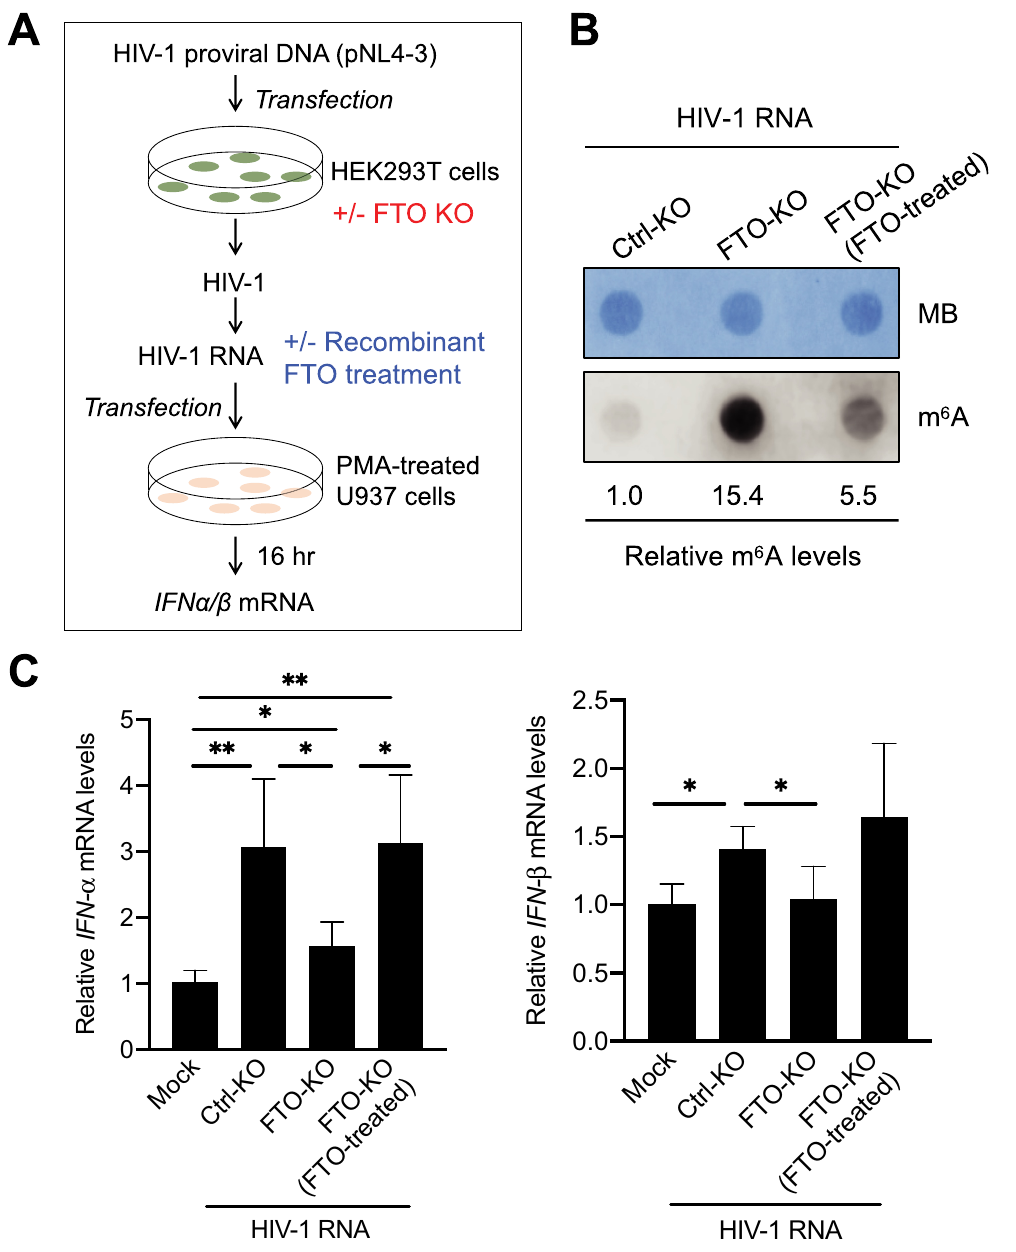
Fig 8. IFN-I mRNA expression is rescued in U937 cells transfected with m 6 A-increased HIV-1 RNA upon recombinant FTO treatment. (A) A schematic diagram of the experimental approach. (B) HIV-1 RNA isolated from virions generated from FTO-KO HEK293T cells was treated with or without recombinant FTO. HIV-1 RNA derived from Ctrl-KO HEK293T cells was used as a control. m 6 A levels of HIV-1 RNA (50 ng/sample) were measured by the m 6 A dot-blot assay. Methylene blue (MB) staining was used as an RNA loading control. (C) HIV-1 RNA (250 ng) was transfected in PMA-differentiated U937 cells (5 × 10 5 ). Mock transfection of U937 cells without RNA was used as a negative control. At 16 hr post-transfection, IFN- α and IFN- β mRNA levels were measured by RT-qPCR. The results are shown as means ± S.D. of four biological samples from two independent experiments. � P < 0.05, �� P < 0.01. Un-paired t-test was used for statistical